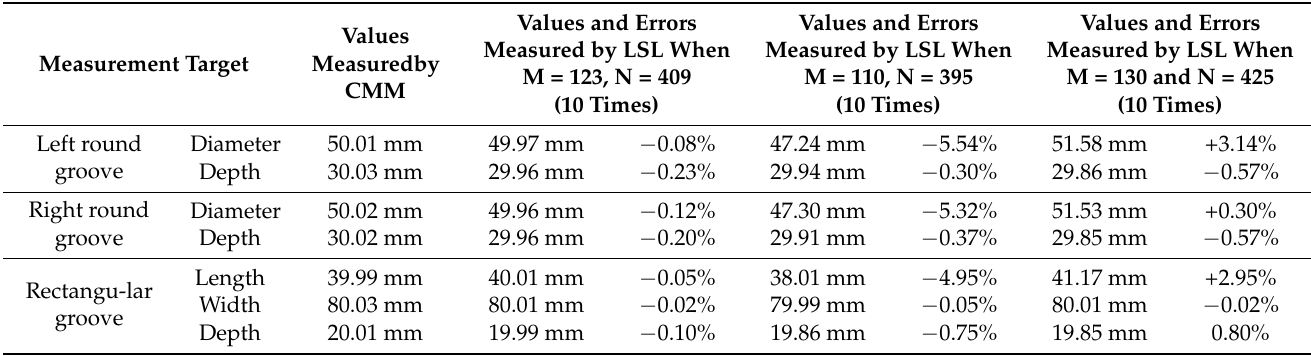
Table 2. Comparison of measurement